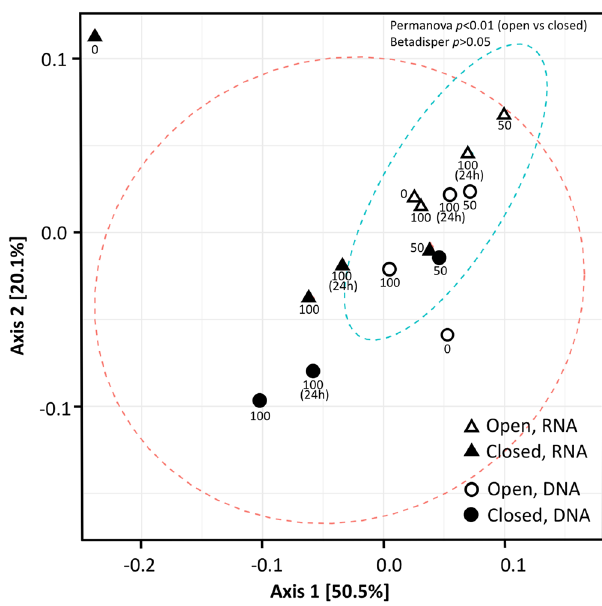
Fig. 5 Principal coordinate analysis plot of weighted UniFrac distances. Principal coordinate analysis plot of weighted UniFrac distances based on 16 S rRNA gene (DNA) and 16 S rRNA (RNA) from the surface layer of each incubation. The 0_Closed_6h_DNA sample was deemed an outlier due to contamination and was therefore not included in this analysis (see Methods for details). Permanova identi fi ed a signi fi cant difference between open and closed conditions ( p < 0.001), but not between DNA and RNA. The ellipses represent the 95% con fi dence interval. 0, 50, and 100 denotes distance along the transect in